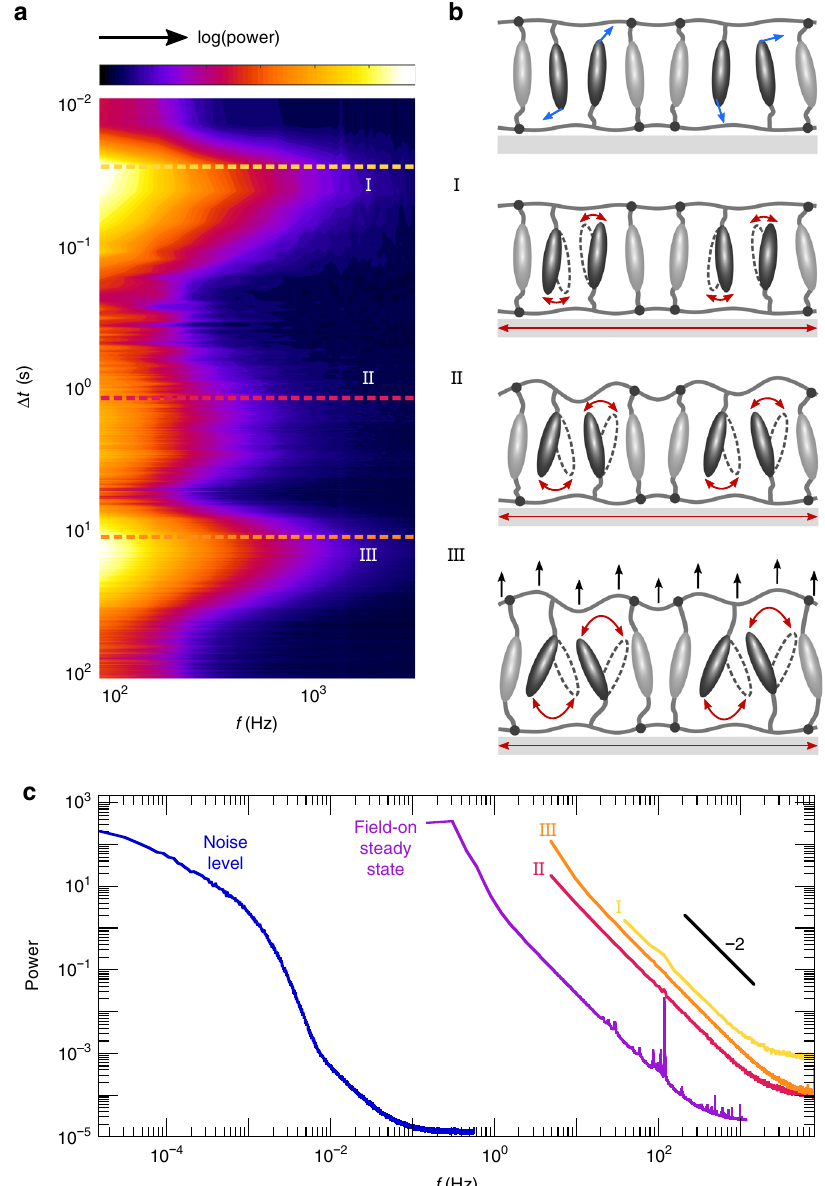
Fig. 4 Frequency-resolved analysis of morphing kinetics. a Spectrogram of the dynamics after fi eld switch-on at Δ t = 0. Each horizontal strip represents one power spectrum of the temporal speckle intensity, averaged over 0.015 mm 2 surface. Three distinct dynamic stages can be identi fi ed. The colour scale ranges from − 3 to − 0.1. b Illustration of the fi eld-off steady state (top) and morphing stages. Only the inter-electrode region is drawn. (I) Dielectric interactions drive the polar mesogens to oscillate along the AC fi eld lines. (II) Under resonance conditions, the pendant and crosslink mesogens start moving cooperatively and plasticize the network. (III) A feedback loop of network weakening and increased oscillation amplitude causes ampli fi cation of the free volume, culminating in microscopic expansion. c Power spectra matching the indicated cross-sections in a . All stages exhibit high-frequency motions that are ballistic in nature i.e. characterized by power law − 2. By contrast, a static reference sample (blue line) obeys a complex f